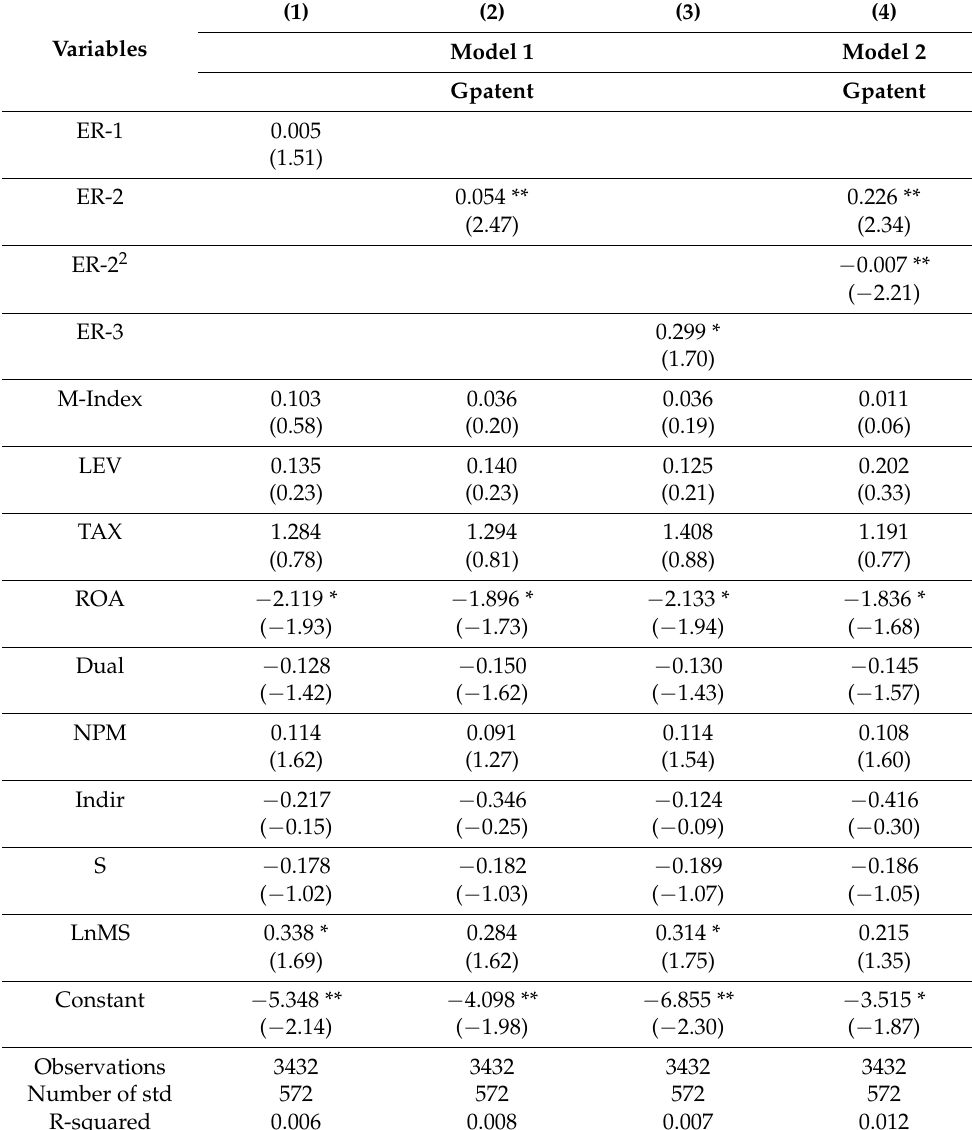
Table 3. Empirical